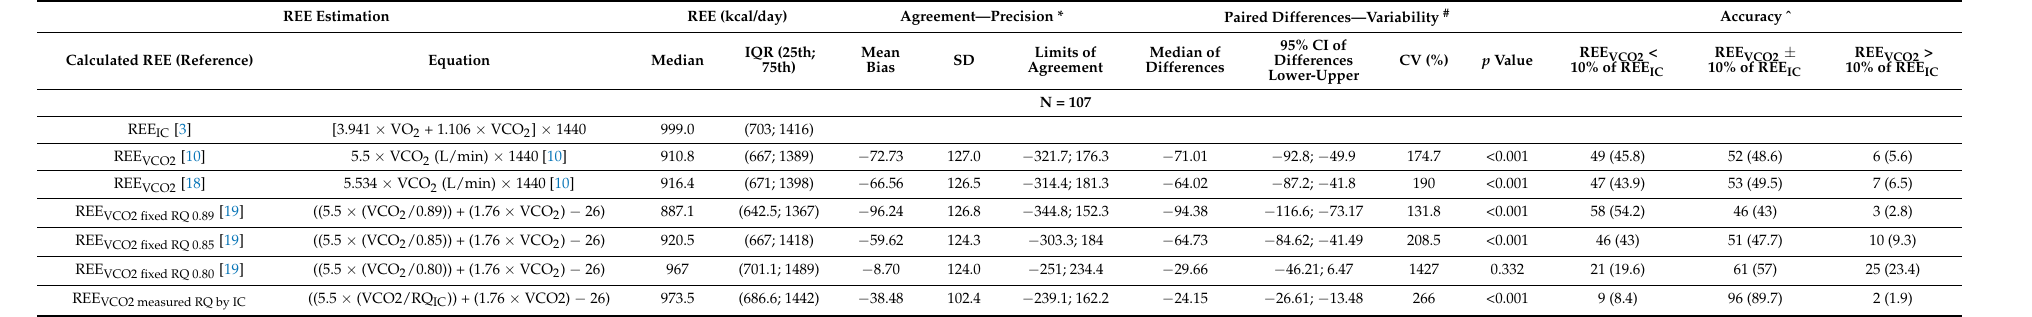
Table 3. Comparison analysis between the VCO 2 derived values and the resting energy expenditure measured by indirect calorimetry. REEEstimation REE(kcal/day) Agreement—Precision* PairedDifferences—Variability # Accuracyˆ Equation Medianof